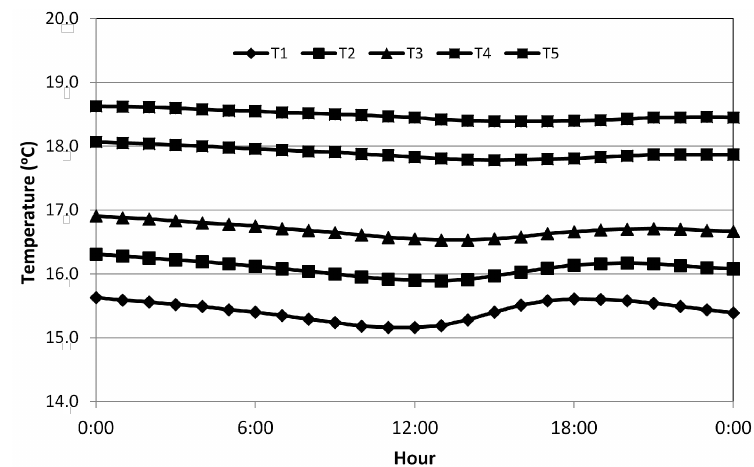
Figure 7. Temperature change in the wall for 3 February